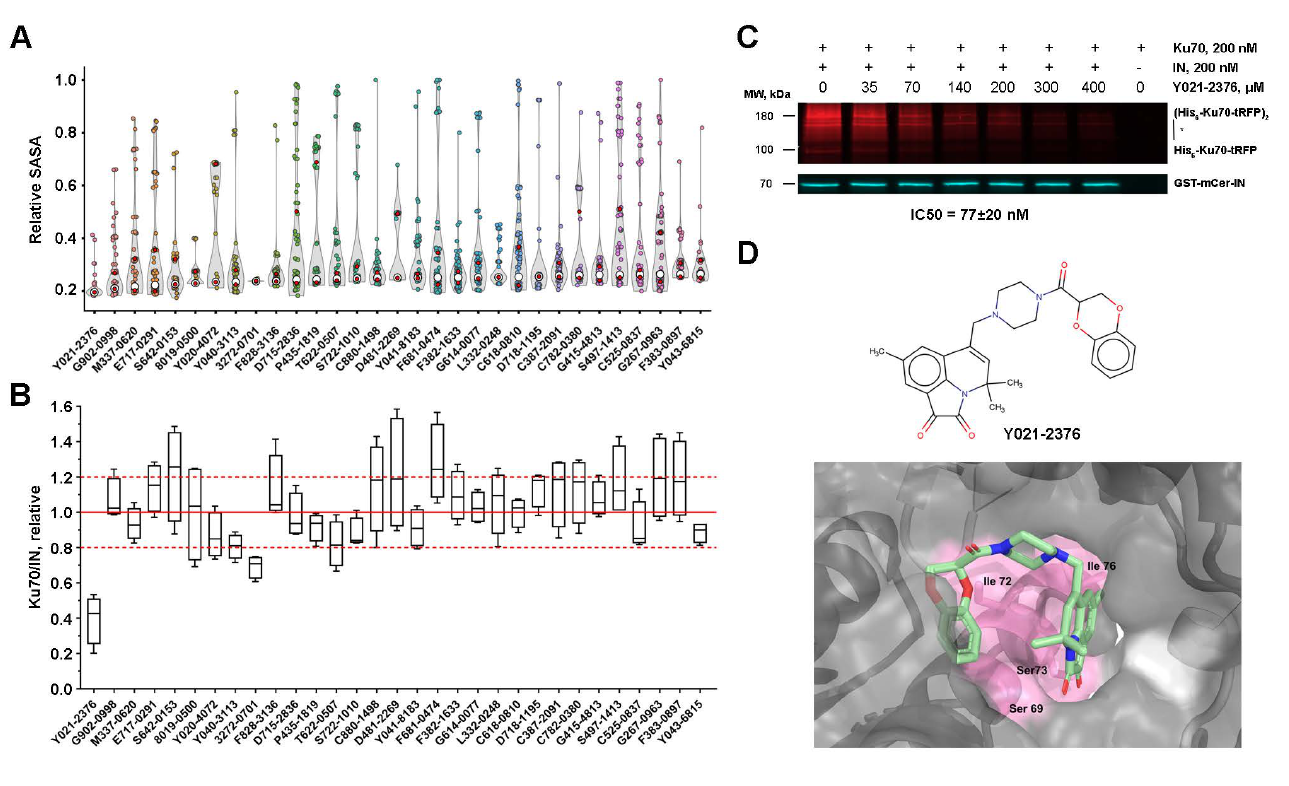
Figure 4. Y021-2376 blocks HIV-1 IN binding to Ku70. ( A ) Distribution of relative SASA S69 + I72 + S73 + I76 calculated for complexes of the Ku heterodimer with top 31 investigated com- pounds. White dots correspond to the median of the distributions. ( B ) The effect of 100 µ M com- pounds on the Ku70/IN complex formation. ( C ) Fluorescent pull-down assay analysis of the in- teraction of His6-Ku70-tRFP (200 nM) and GST-mCer-IN (200 nM) in the presence of an increasing concentration of Y021-2376. ( D ) Chemical structure of the most active compound Y021-2376 (top panel) and probable inhibitor position in the Ku70/Ku80 heterodimer (bottom panel). Ku70 residues involved in HIV-1 IN binding are pink. Ku70 surface is colored in dark gray and Ku80 in light